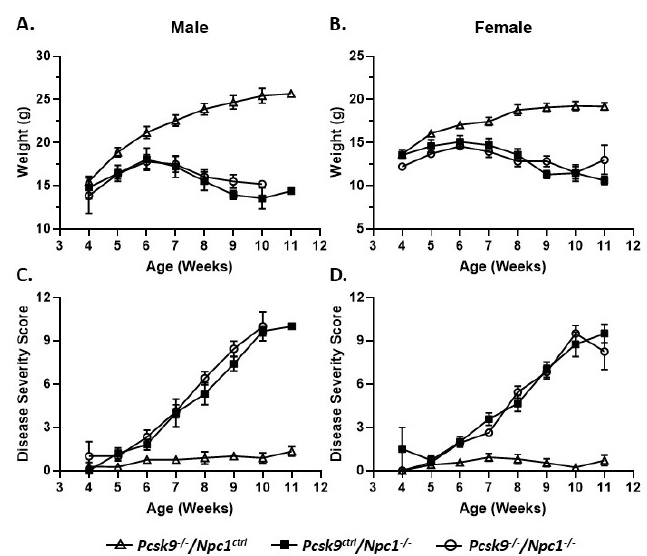
Figure 1. Weight and disease progression in proprotein convertase subtilisin/kexin type 9 deficient mice ( Pcsk9 -/- ) in the context of NPC1 disease. Male ( A ) and female ( B ) mice were weighed weekly. Pcsk9 -/- /Npc1 ctrl mice had a normal weight gain profile. Npc1 mutant mice begin to lose weight at ~6 weeks of age and continued thereafter. There was no significant difference observed between Pcsk9 ctrl /Npc1 -/- and Pcsk9 -/- /Npc1 -/- mice. Male ( C ) and female (D) mice were assessed on a weekly basis for disease severity: grooming, gait, extent of kyphosis, hindlimb clasp and ability to walk along the ledge of the cage. As expected, Pcsk9 -/- /Npc1 ctrl mice displayed negligible scores throughout the course of the assessments. The Npc1 mutant mice exhibited an increase in disease severity starting at ~6 weeks of age and continued thereafter. No significant difference was observed between Pcsk9 ctrl /Npc1 -/- and Pcsk9 -/- /Npc1 -/- groups.